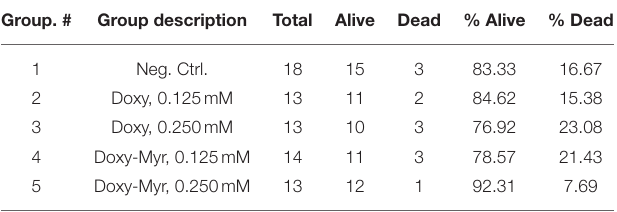
TABLE 1 | Chick embryo toxicity of Doxycycline and Doxy-Myr. Group. #